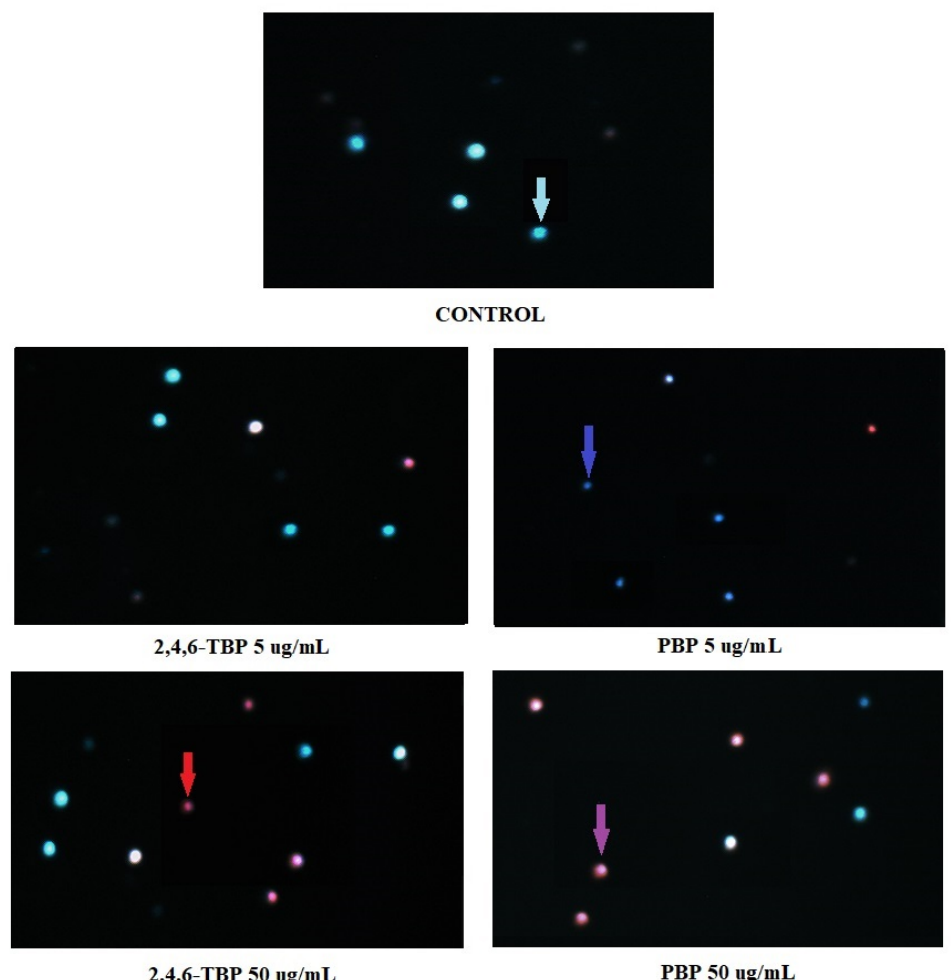
Figure 6. Apoptotic changes in PBMCs incubated with DMSO (control) as well as 2,4,6-TBP and PBP at 5 µ g/mL and 50 µ g/mL. The cells were stained with Hoechst 33342 and PI. Viable cells (blue fluorescence), early apoptotic cells (intense bright-blue fluorescence), late apoptotic cells (blue/violet fluorescence), and necrotic cells (red